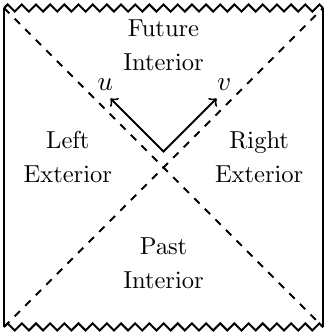
Figure 1 . Penrose diagram for the two-sided black branes we consider. This geometry is dual to a thermo(cid:12)eld double state TFD made by entangling two copies of the boundary j i